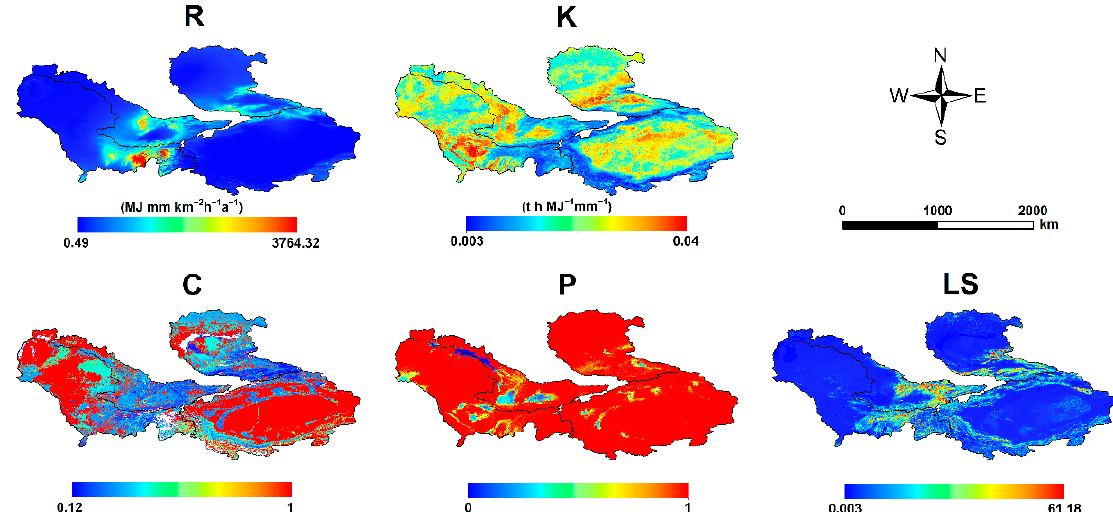
Figure 3. Spatial distribution of the annual mean of SE factors based on the RUSLE model in CA from 1982 to 2017. R represents rainfall erosivity factor, K represents soil erodibility factor, LS represents topographic factor, P represents erosion control practice factor, and C represents vegetation cover factor.